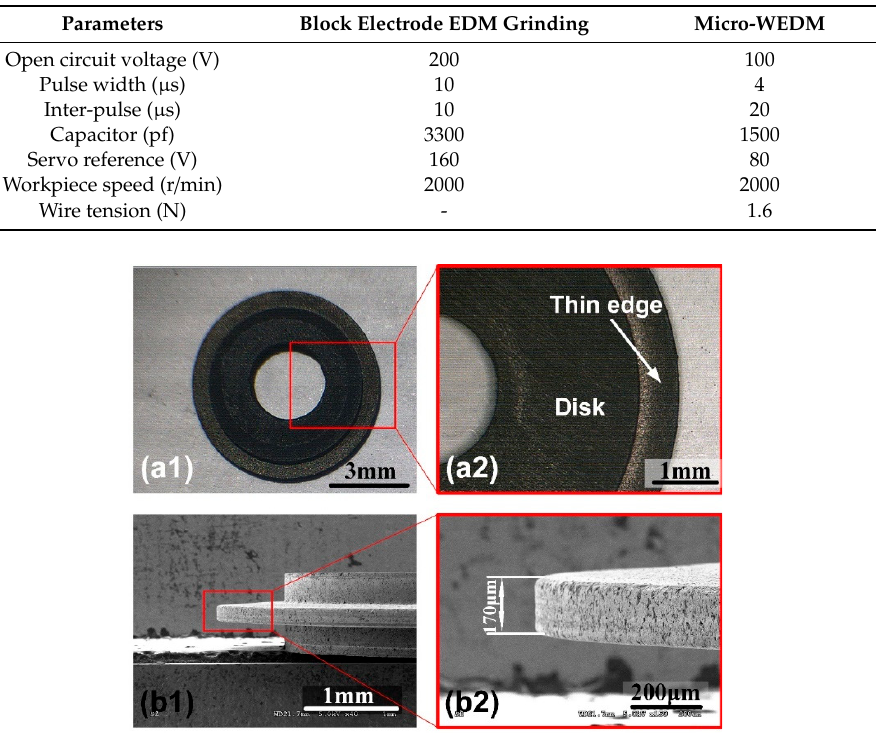
Figure 3. Digital photographs and SEM images of the graphite tool electrode prepared by micro-WEDM with disk high-speed rotation. ( a1 , a2 ) are photograph of the graphite tool electrode and the enlarged view. ( b1 , b2 ) are SEM images of the thin edge of the electrode and the enlarged view.